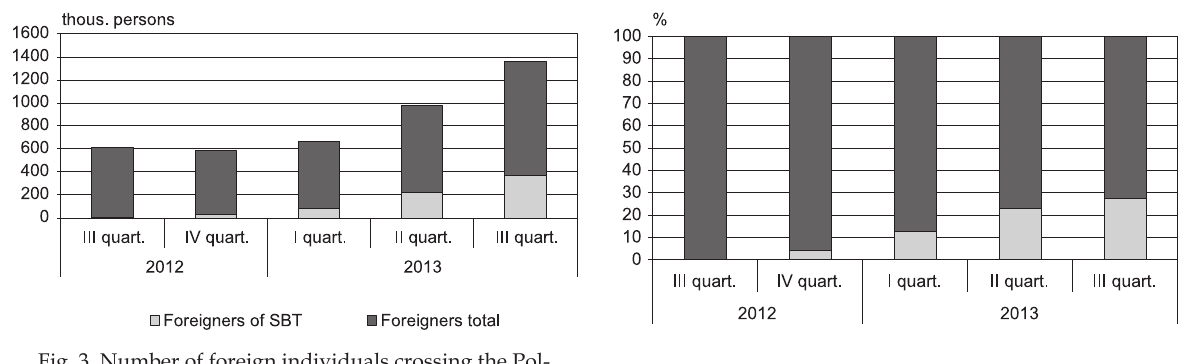
Fig. 3. Number of foreign individuals crossing the Pol- ish-Kaliningrad border, including those with documents